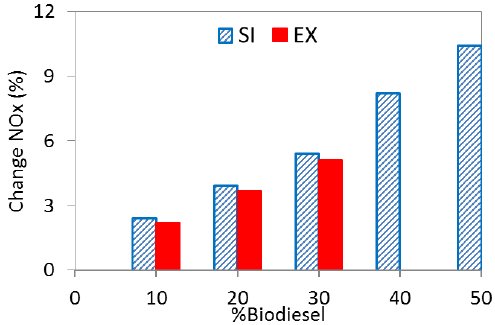
Figure 16. Relationship between NOx emissions and biodiesel blending ratio of simulation (SI) and experiment (EX).